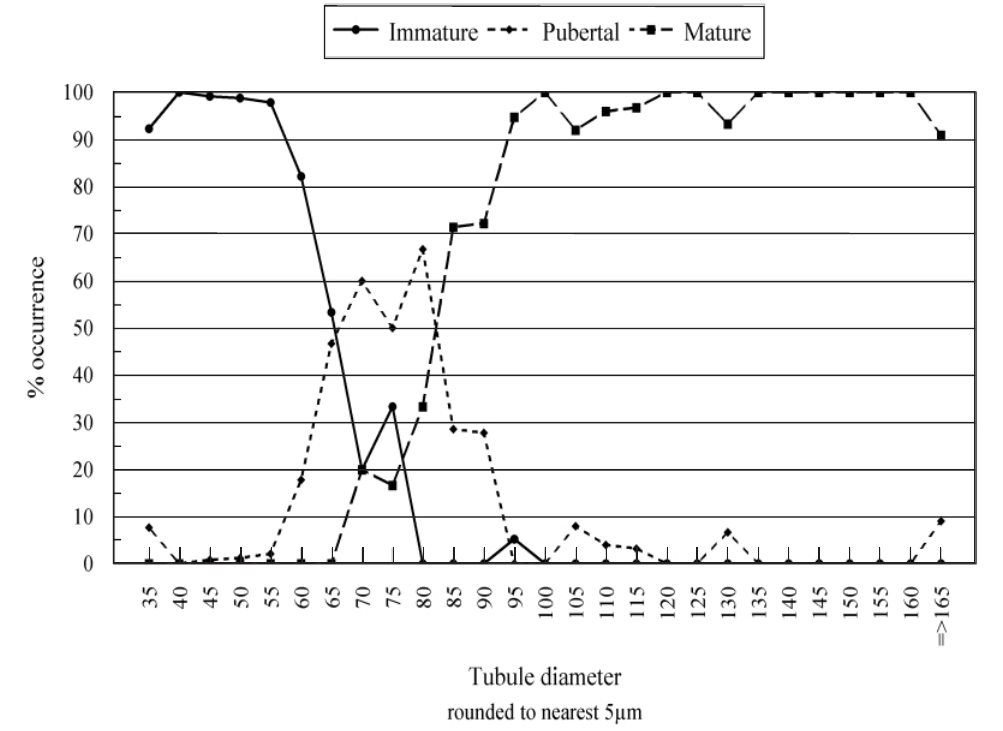
Percentage of each maturity stage by tubule